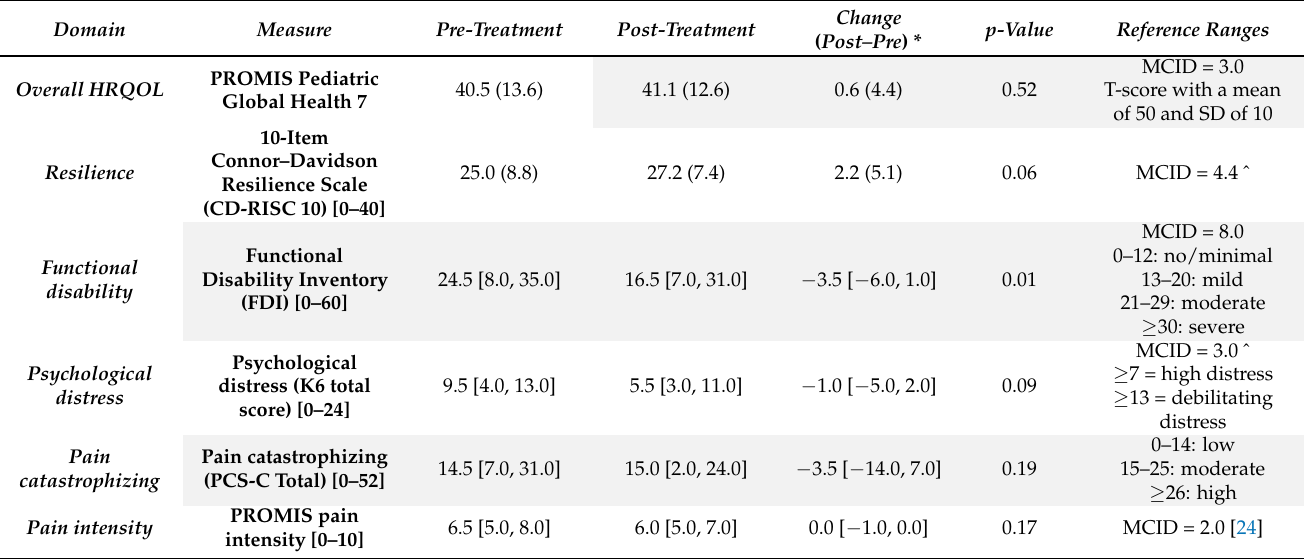
Table 5. Changes in patient-reported outcome measures pre- and post-treatment for youth with CMP ( N =